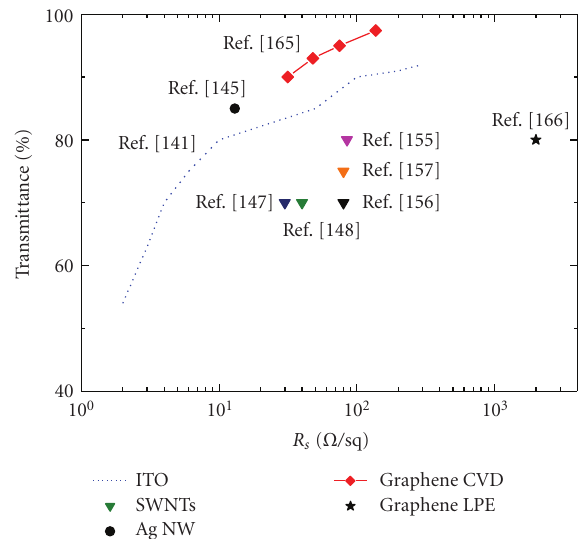
Figure 6: T versus R s spectrum for di ff erent TCs. Legend: dotted line: ITO; red rhombuses: CVD graphene; black star: vacuum filtration of liquid phase-exfoliated (LPE) graphene; black dot: silver nanowires; triangles: SWNT